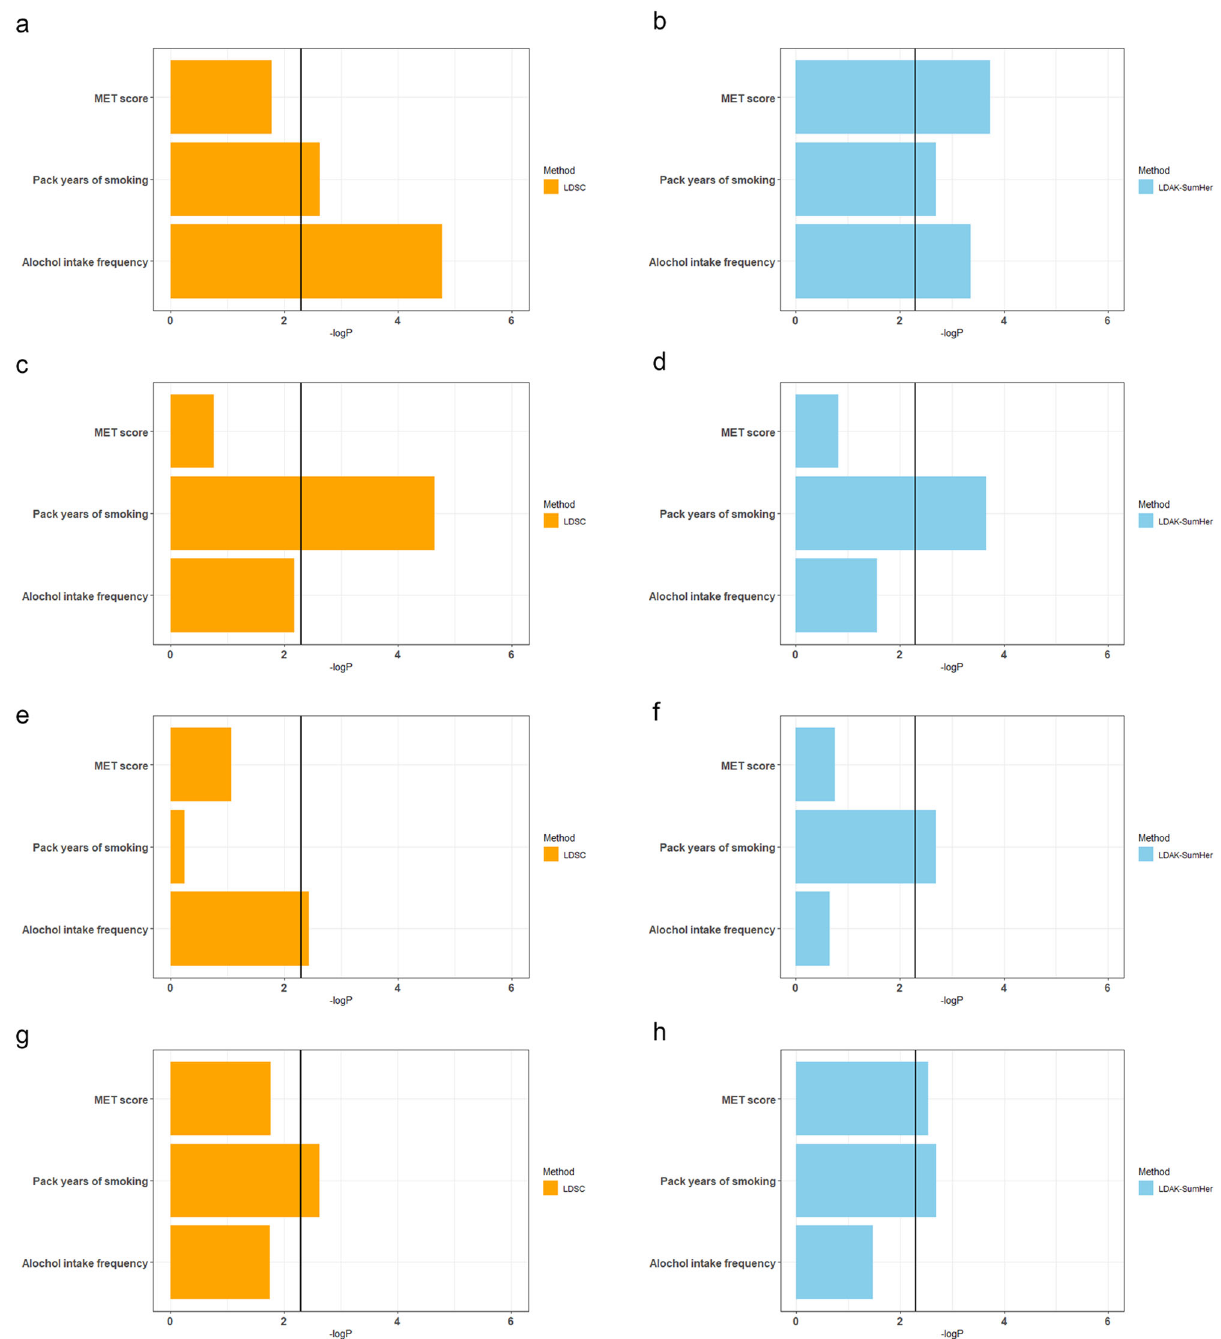
Fig. 3 Bar plots of G × E interaction heritability in obesity-related traits. Comparison of results for G × E interaction heritability calculated by LDSC ( a , c , e , g ) and LDAK-SumHer ( b , d , f , h ) in waist circumference ( a , b ), hip circumference ( c , d ), WHRadjBMI ( e , f ), and body fat percentage ( g , h ). The x -axis indicates the – log P -value. MET metabolic equivalent task, WHRadjBMI waist-to-hip ratio adjusted with body mass 10 G × E interaction heritability index, LDSC linkage disequilibrium score regression, LDAK-SumHer linkage disequilibrium adjusted kinships – software for estimating SNP heritability from summary